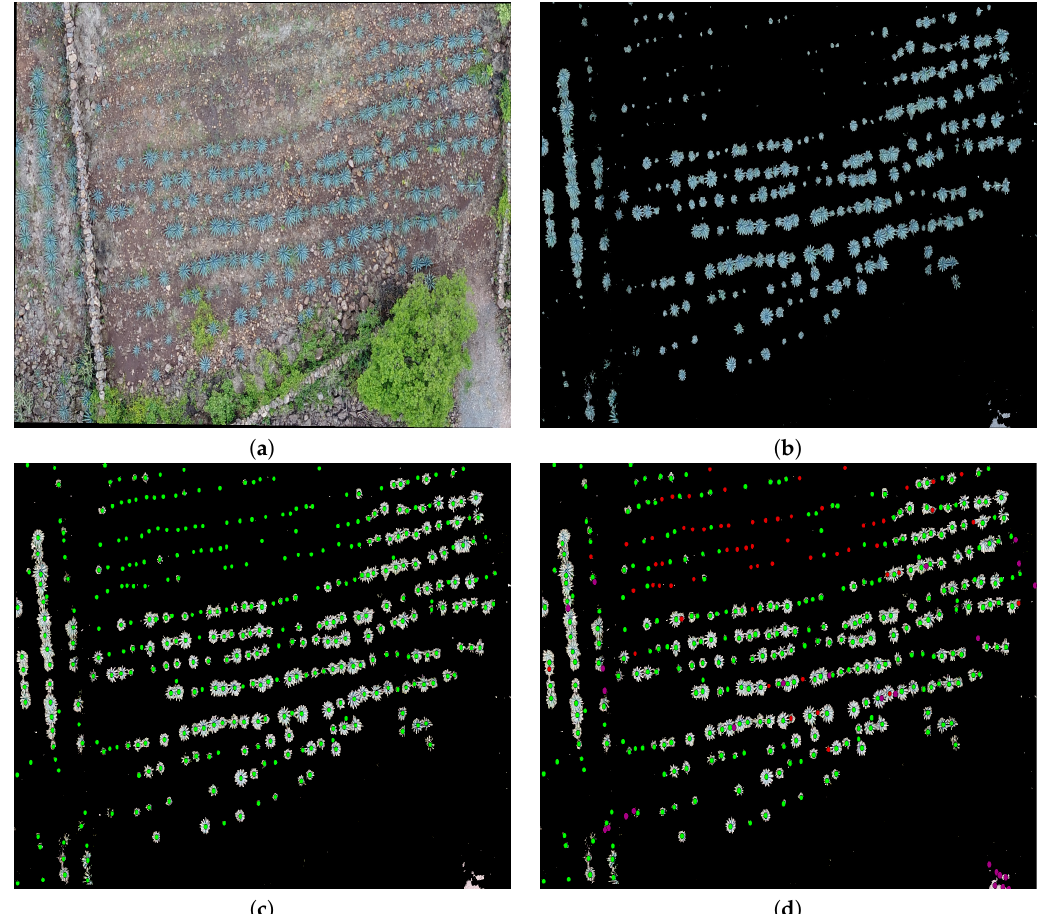
Figure 14. ( a ) A polygon in blue in Field 2 (Figure 3), ( b ) an extracted agave layer by means of the methodology in [2], ( c ) agave plants counted by an expert (ground truth), and ( d ) agave plants detected by the proposal: those not detected appear in red (false negative), while false positives appear in